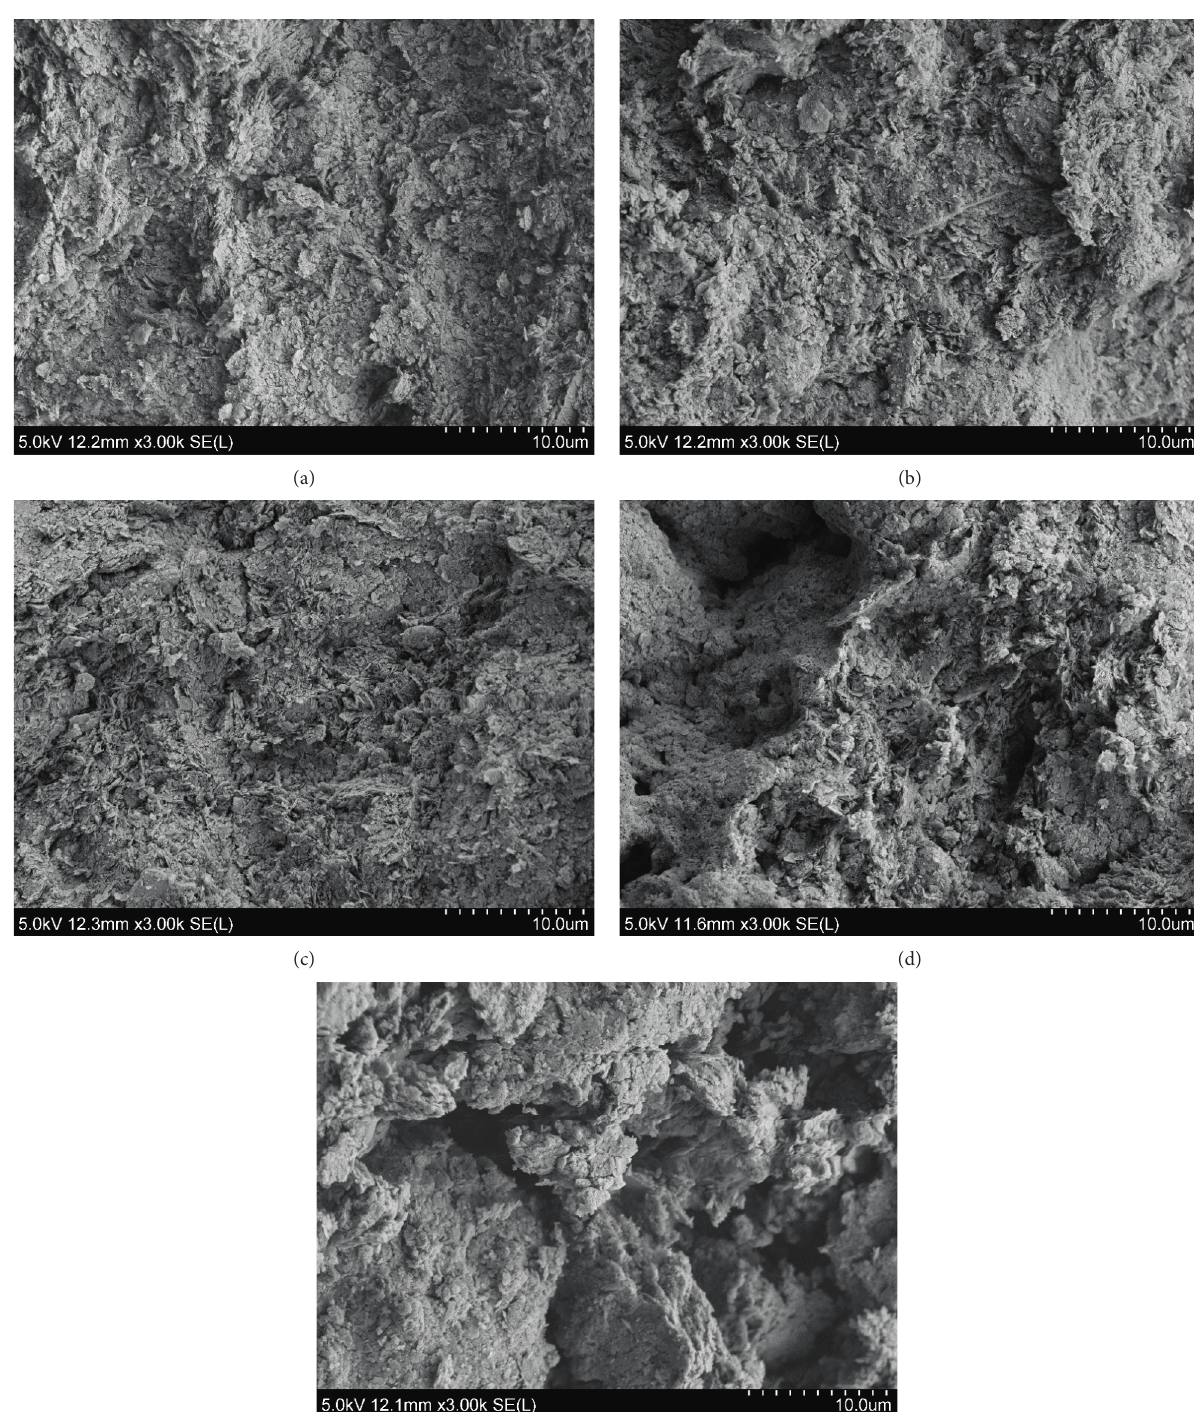
Figure 6: Microstructure of remolded red clay under different zinc ion concentrations. (a) Zinc ion concentration of 0%. (b) Zinc ion concentration of 0.1%. (c) Zinc ion concentration of 0.2%. (d) Zinc ion concentration of 0.5%. (e) Zinc ion concentration of